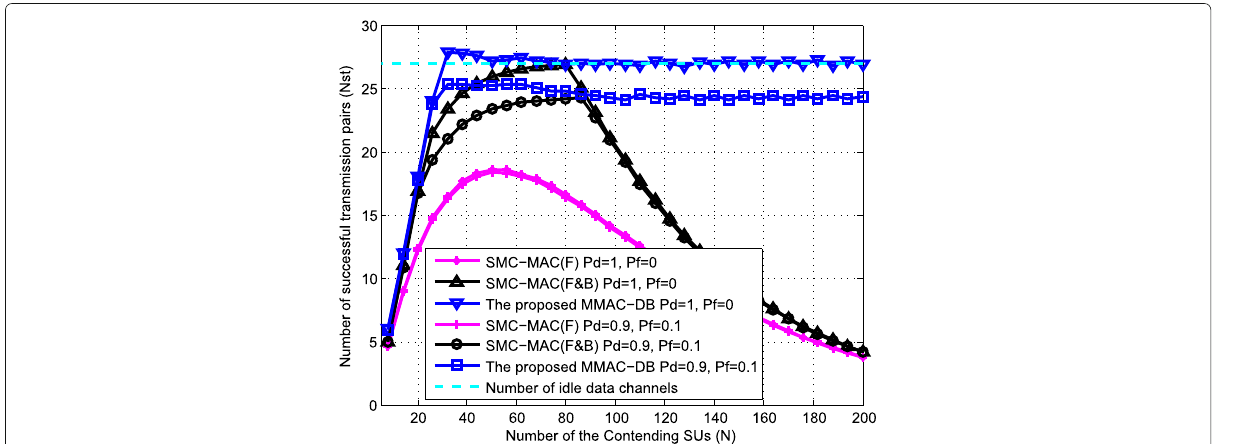
Fig. 13 Number of successful transmission pairs with M = 30, α = 0.1. The number of the successful transmission pairs in scene 3